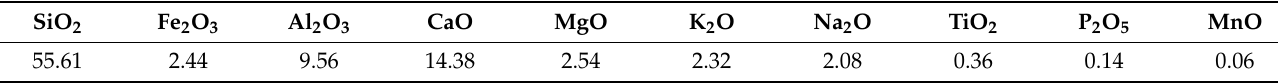
Table 2. The chemical composition of Taklamakan Dune (%).